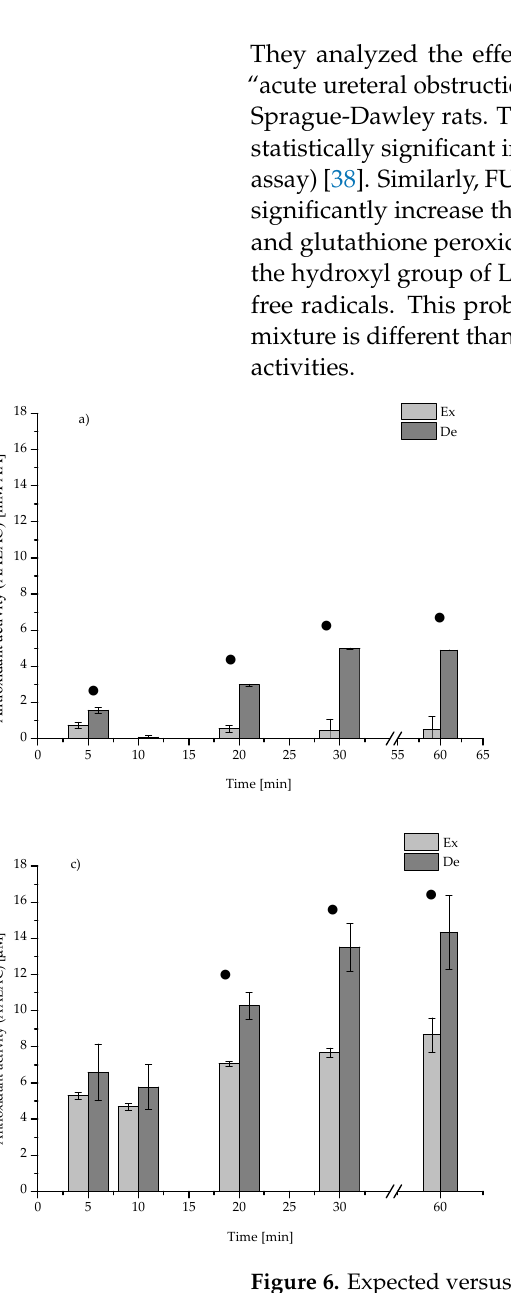
* SD—standard deviation.